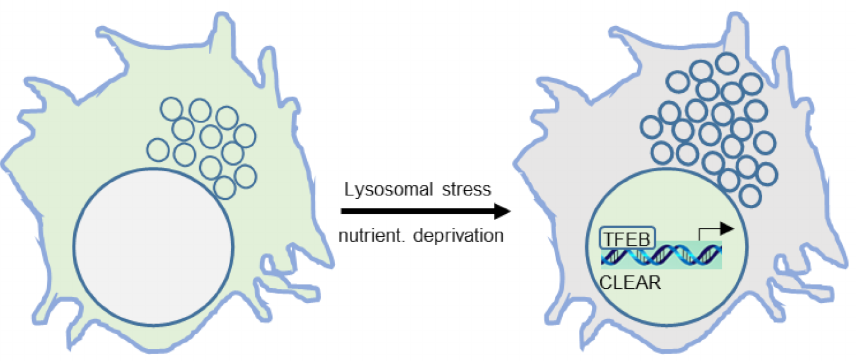
Figure 2. Transcriptional regulation of autophagy and lysosomal biogenesis, exemplified by tran- scription factor EB (TFEB) enriching in nuclei where it binds to the coordinated lysosomal expression and regulation (CLEAR) element in DNA, which is followed by transcription and